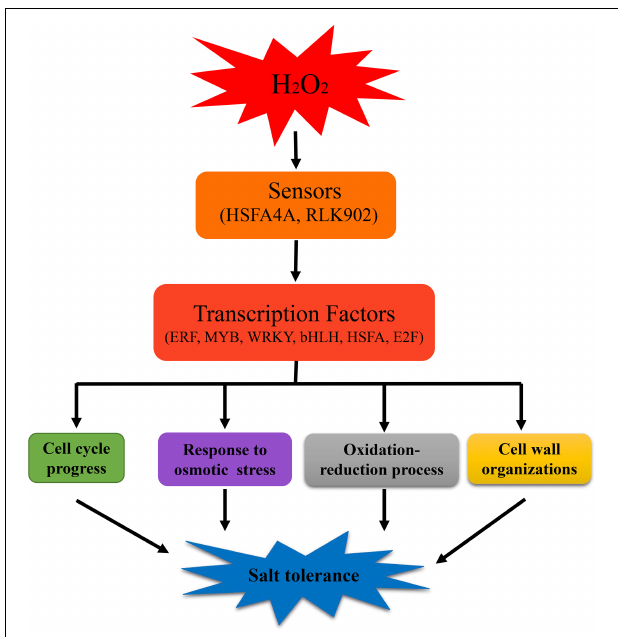
FIGURE 7 | A working model of the mechanism underlying H 2 O 2 pretreatment to improve salt tolerance in Arabidopsis. After H 2 O 2 pretreatment, plants respond to salt stress via complex signal transduction pathways. We speculate that HSFA4A and RLK902 act as sensors in the H 2 O 2 pretreatment process, transmitting the H 2 O 2 signal to activate transcription factors, including those in WRKY, ERF, MYB, HSFA, bHLH, and E2F families. These transcription factors activate a series of genes with responses in cell cycle progress, osmotic stress, redox processes, and cell wall tissue, ultimately improving plant salt